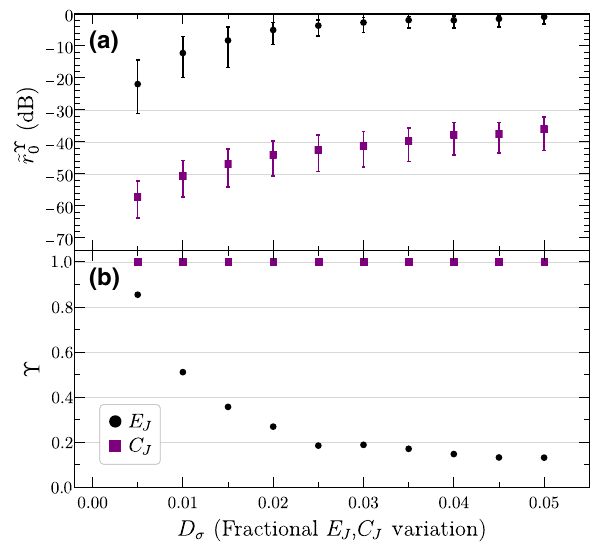
FIG. 11. (a) Median of r ϒ (defined in Appendix D 1 as the 0 extinction ratio for devices with less than 1 dB of insertion loss), ˜ r ϒ , as a function of the standard deviation of the E J or C J noise 0 distribution D σ as indicated by the legend. Error bars indicate for the spread from the first quartile to the third quartile of r ϒ 0 each value of D σ . (b) Device yield ϒ (defined in Appendix D 1 as the fraction of devices with less than 1 dB of insertion loss) as a function of D σ . The parameters for ideal tuning are the same as in Fig.